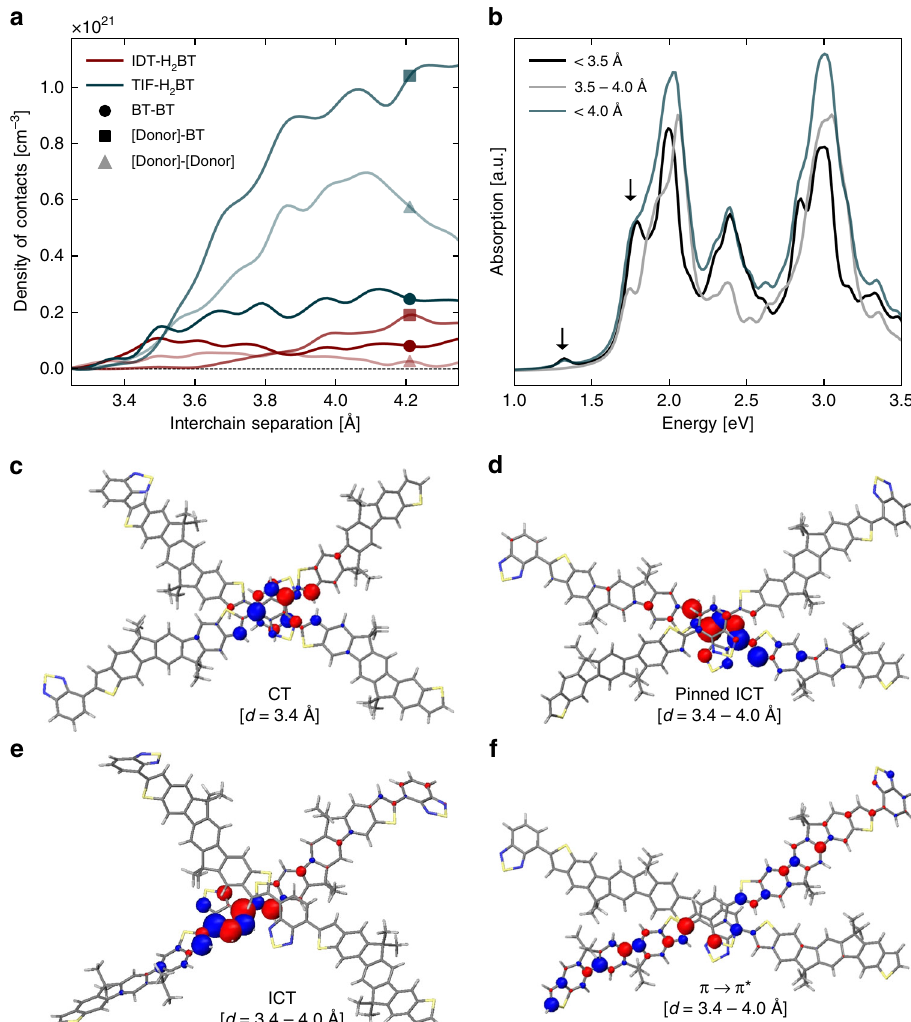
Fig. 4 Theoretical calculations of excited states at close contact points. a Radial distribution functions for various interchain coupling motifs for IDT-H 2 BT and TIF-H 2 BT. b Absorption intensity for the closest interchain coupling motif for TIF-H 2 BT, shown below. For various model geometries for the close crossing of two polymer chains, transition densities for absorption features are shown: the CT formed at an interchain separation of 3.4 Å ( c ), and the pinned ICT ( d ), ICT ( e ), and π ! π (cid:4) ( f ) transitions at various geometries in the range 3.4 – 4.0